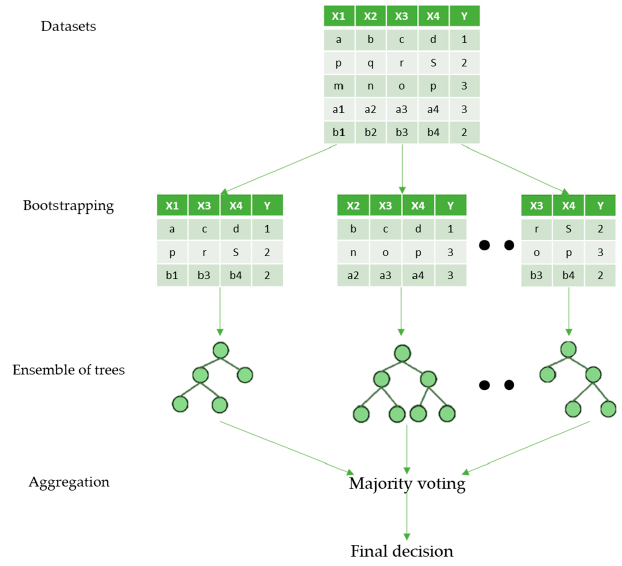
Figure 3. Steps involved in solving a classification/regression problem using